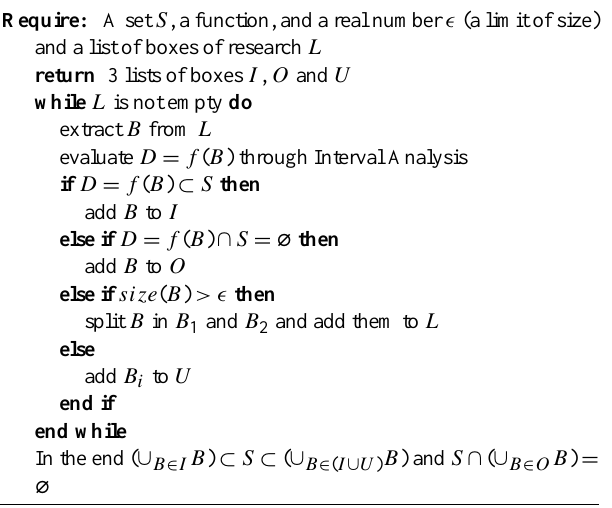
Algorithm 1 Set Inversion Via Interval Analysis (SIVIA) al-